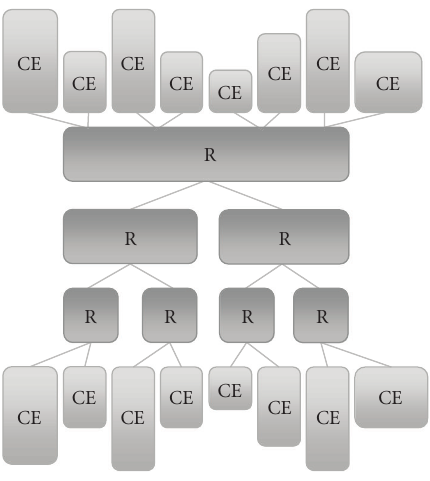
Figure 4: The DRAFT topology. Communicating elements “CEs” are connected to the root and base-levels of a fat-tree